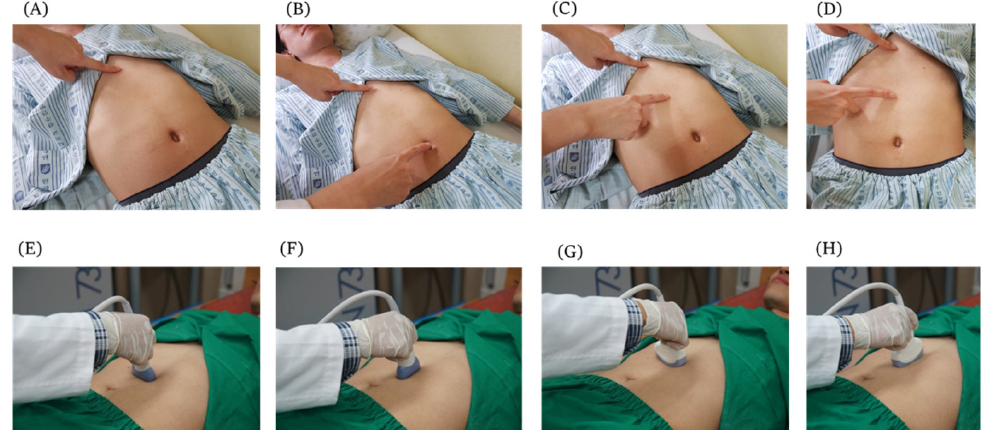
Figure 2. Palpation and probe placement for ultrasound imaging of acupoint CV12 ( A ) Palpitate xiphisternal junction ( B ) Palpitate center of umbilicus ( C ) Palpitate midpoint of the line connecting the end of xiphisternal junction and the center of the umbilicus. ( D ) High angle view of acupoint CV12. During ultrasound imaging, the probe was placed vertically and horizontally on the skin over acupoint CV12, following the needle direction, in order to efficiently measure the distance from the skin to the peritoneum. ( E ) Linear probe placed on the CV12, perpendicular to median line. ( F ) Linear probe placed on the CV12, parallel to median line. ( G ) Convex probe placed on the CV12, perpendicular to median line. ( H ) Convex probe placed on the CV12, parallel to median line.